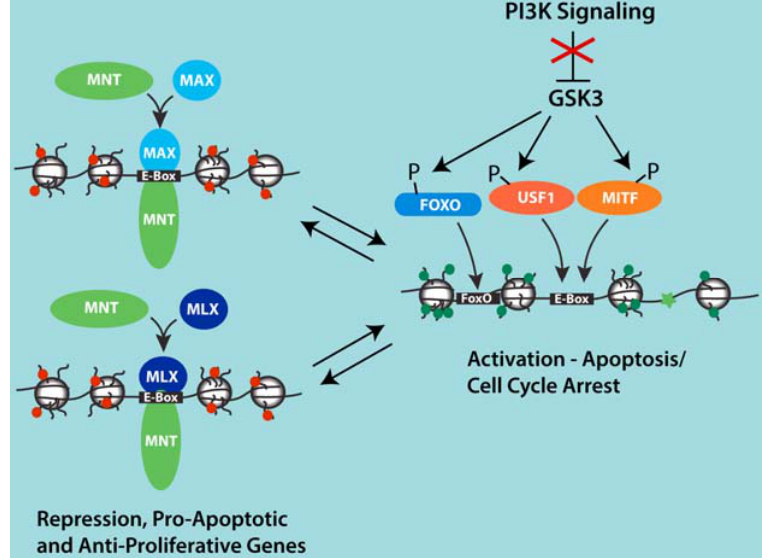
Figure 2. Model for competition between MNT ‐ MAX and USF1 and MITF at a group of shared target genes involved in apoptosis and cell cycle arrest that are induced upon PI3K inhibition. Inhibition of PI3K signaling activates GSK3 and leads to the phosphorylation of USF1, MITF and FOXO transcription factors. Through mechanisms that remain unclear, phosphorylation by GSK3 is associated with the displacement of MNT ‐ MAX with USF1 and MITF complexes at Ebox sites and the binding of FOXO factors at adjacent sites in proximal promoter regions of several genes induced by PI3K inhibition. This set of genes appears to not be regulated by MYC ‐ MAX complexes. However, repression of these genes by MNT may cooperate with PI3K signaling and elevated MYC to promote proliferation and cell expansion by preventing apoptosis that might be otherwise sensitized due to the activities of high MYC.